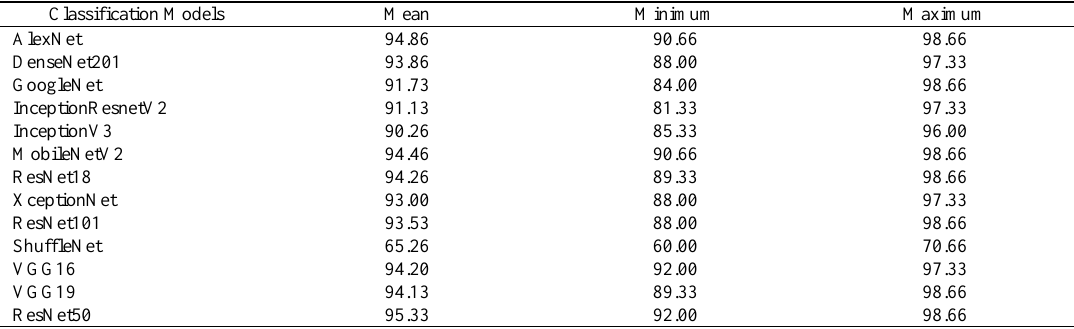
Table 4. Accuracy (%) of different classification models based on SVM using deep features of various